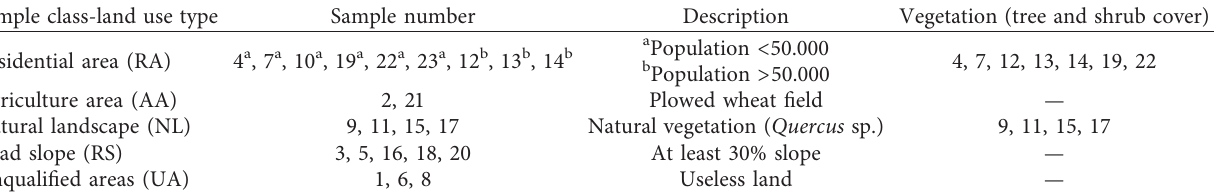
Table 1: Classification of soil